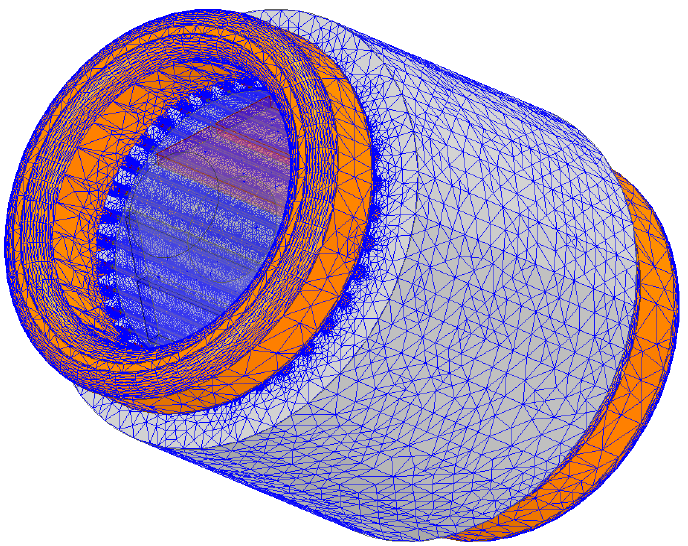
Figure 9. Finite element mesh of the reference model.